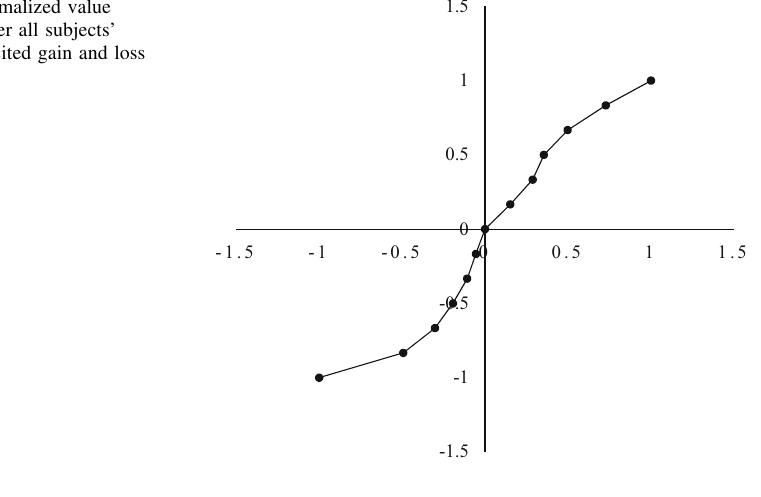
Fig. 4 Normalized value function over all subjects’ average elicited gain and